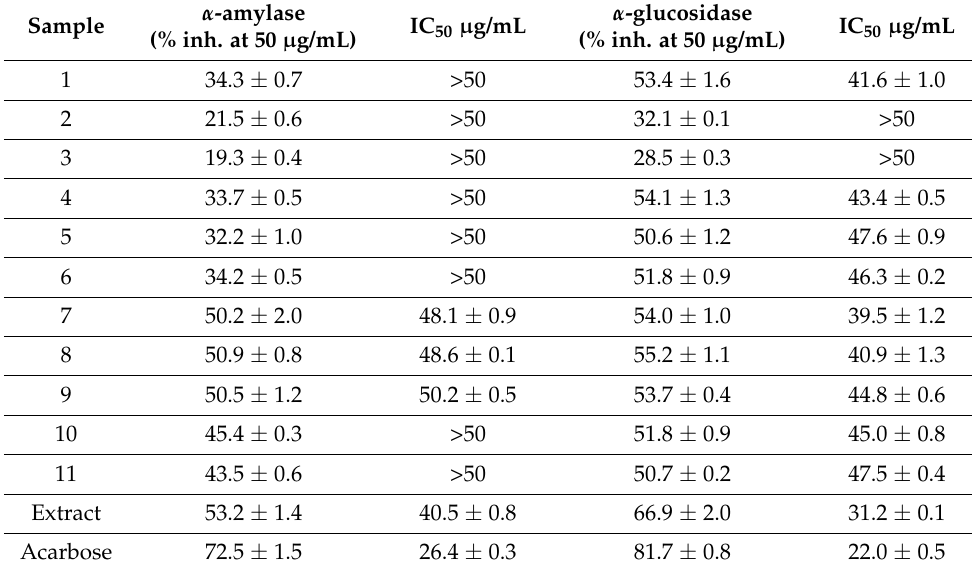
Table 2. Antidiabetic activity ( α -amylase and α -glucosidase inhibition).